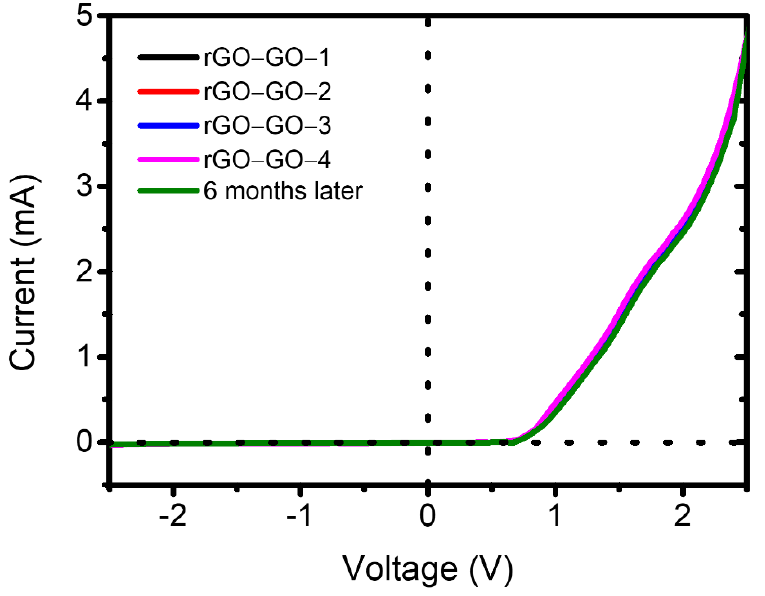
Figure 3. I–V curves of pGO vertical p–n junctions measured multiple times and after six months.